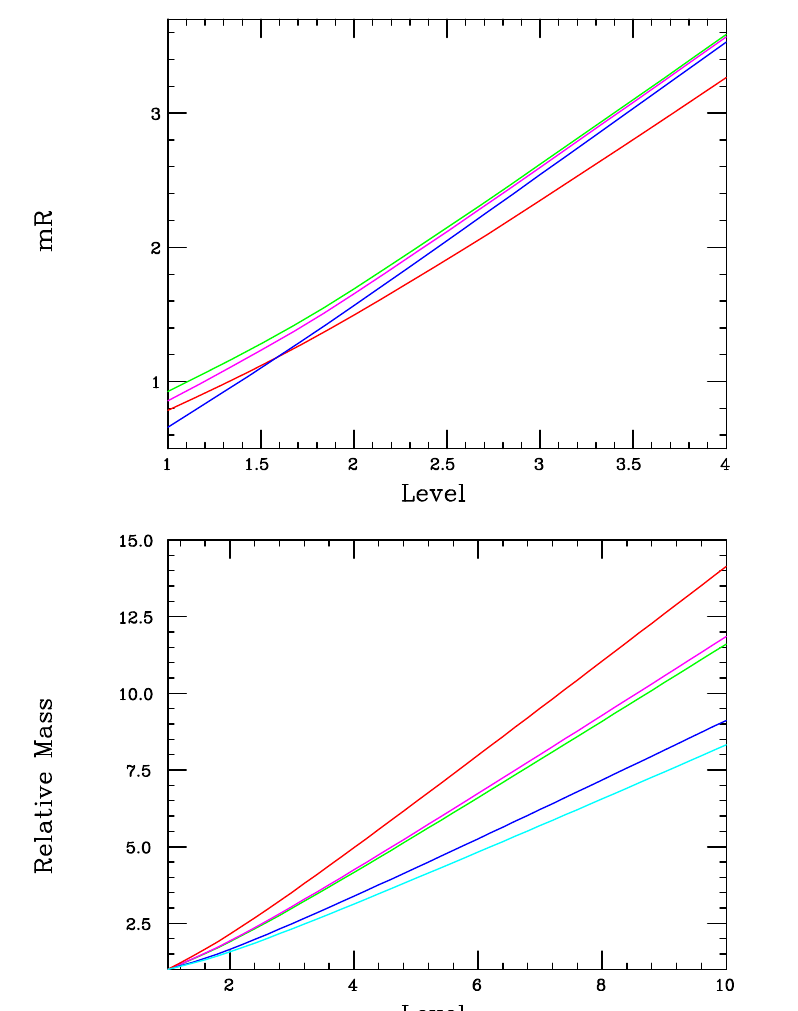
Figure 7 . (Top) Mass spectrum of BM1 for r ha = h=a = 0 : 8 as a function of the level n in units of R (cid:0) 1 for V n (red), (cid:31) n (blue), a n (green) and h n (magenta), respectively. (Bottom) Growth in the mass ratio m V =m V as a function of n for BM1 (green), BM1’ (magenta), BM2 (blue), BM3 (red) n 1 and BM4